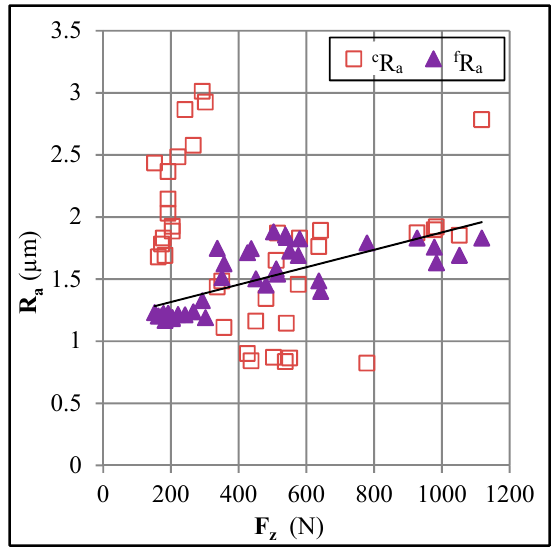
Figure 7. Correlation between the mean roughness and forming force.